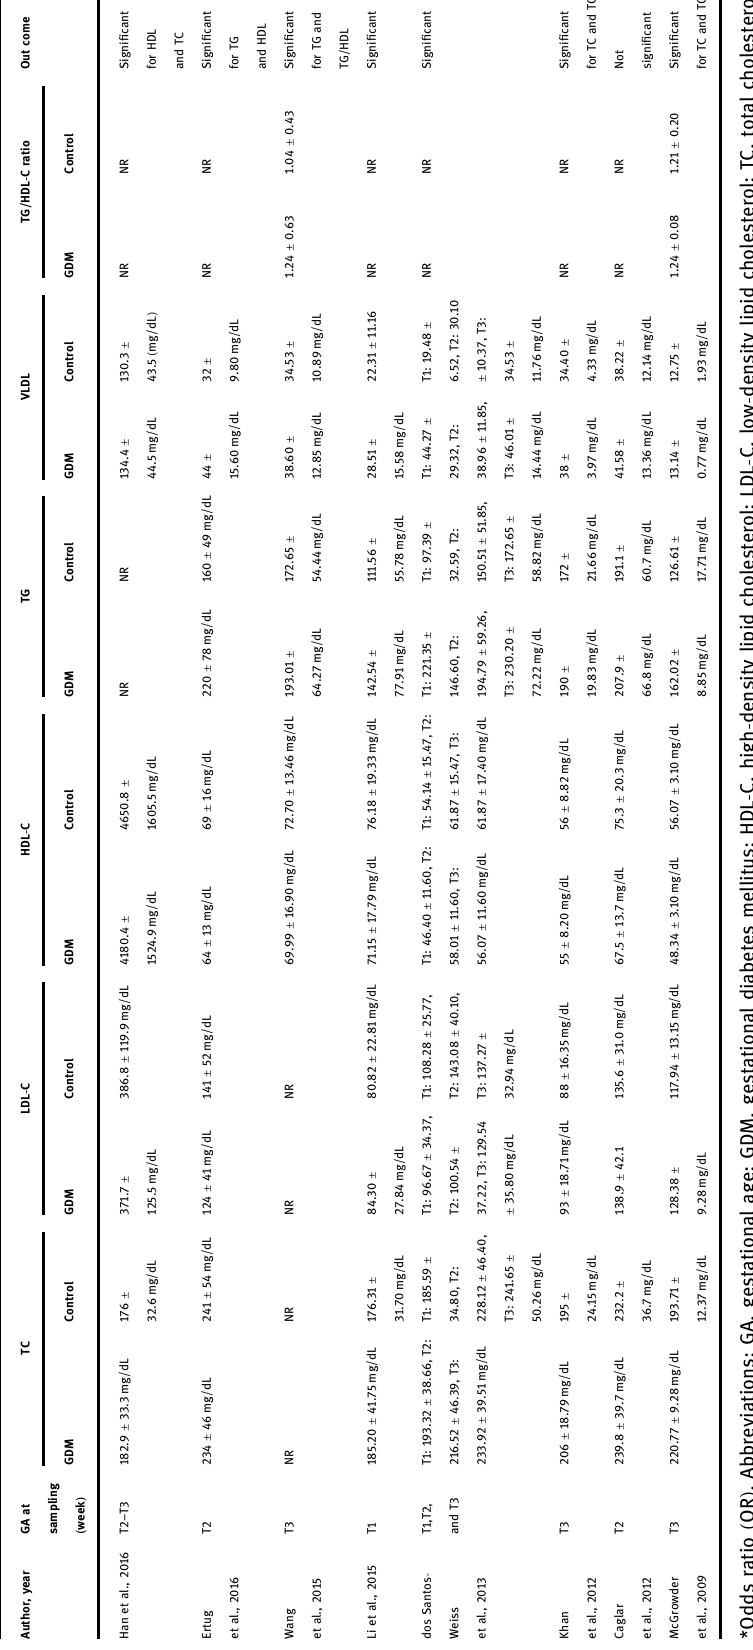
E ff ect of GDM on lipid pro fi le: A systematic review and meta - analysis 